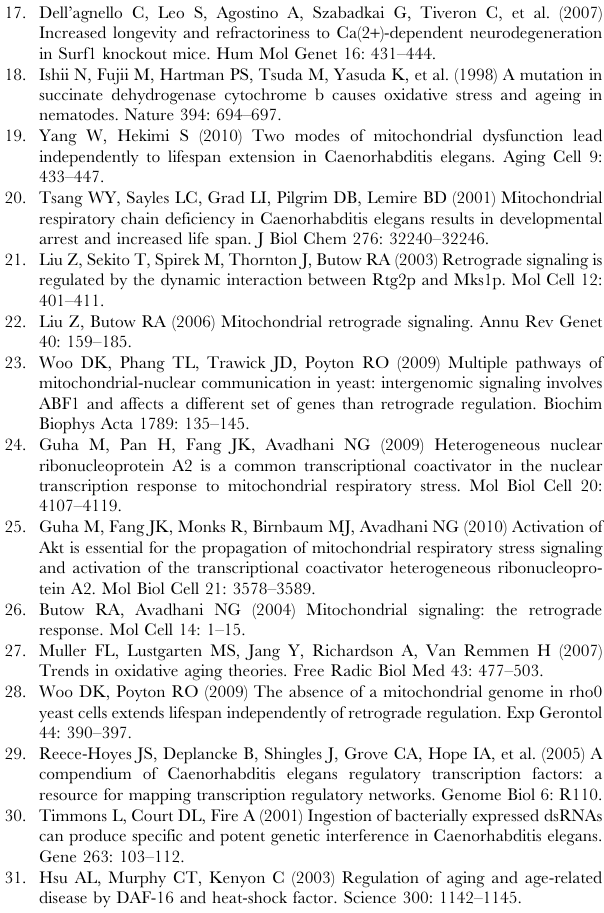
Table S1 Quantitative data and statistical analyses of mean adult lifespan presented in Figure 1 and Tables 1 and 2. Table S2 Quantitative data and statistical analyses of adult lifespan of wild-type, ceh-23 , isp-1;ctb-1 , ceh-23;isp-1;ctb-1 , isp-1 , and ceh-23;isp-1 mutant worms. The data presented in Figure 2 are from Experiments 2 and 6. We tested up to six individuals’ genetic isolates of isp-1;ctb-1;ceh-23 mutant worms and five individuals genetic isolates of ceh-23;isp-1 mutant worms.